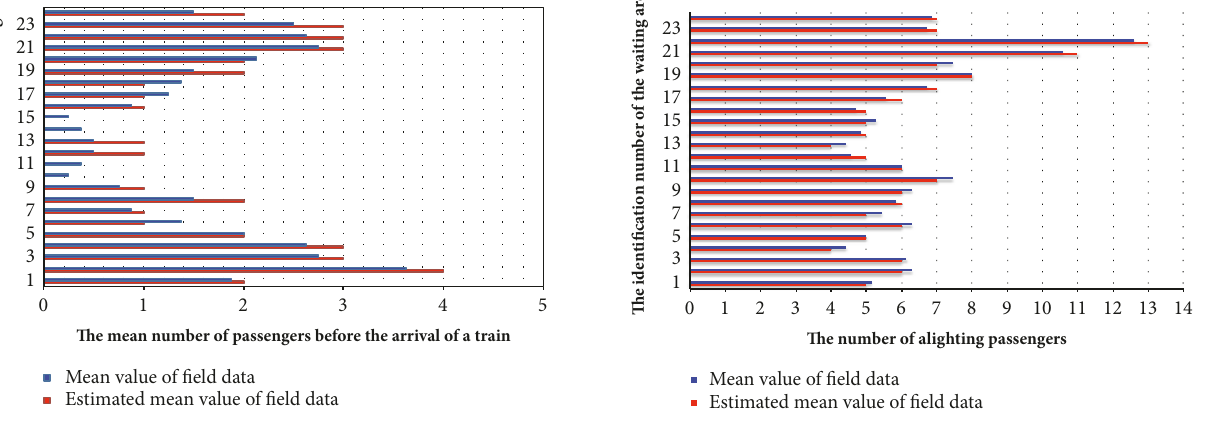
Figure 11: The field number of alighting passengers at each waiting area 𝑁 𝑤 𝑎𝑙𝑖𝑔ℎ𝑡 with Anheqiao North